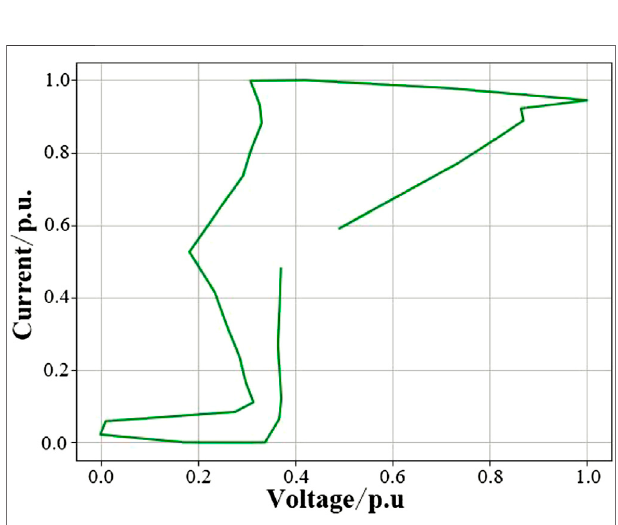
FIGURE 6 | V – I trajectory of mixed state with electric bicycles and hairdryer both